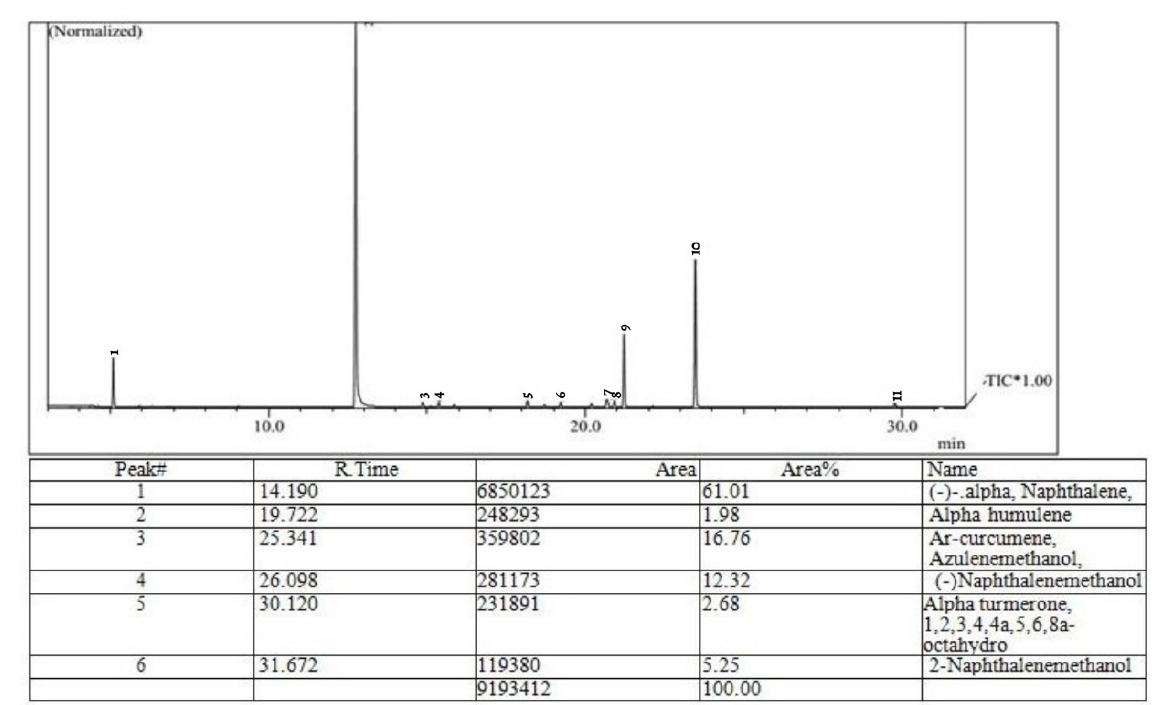
Figure 10. Purity of comerrcially essential oil tested using gas chromatography-mass spectroscopy.